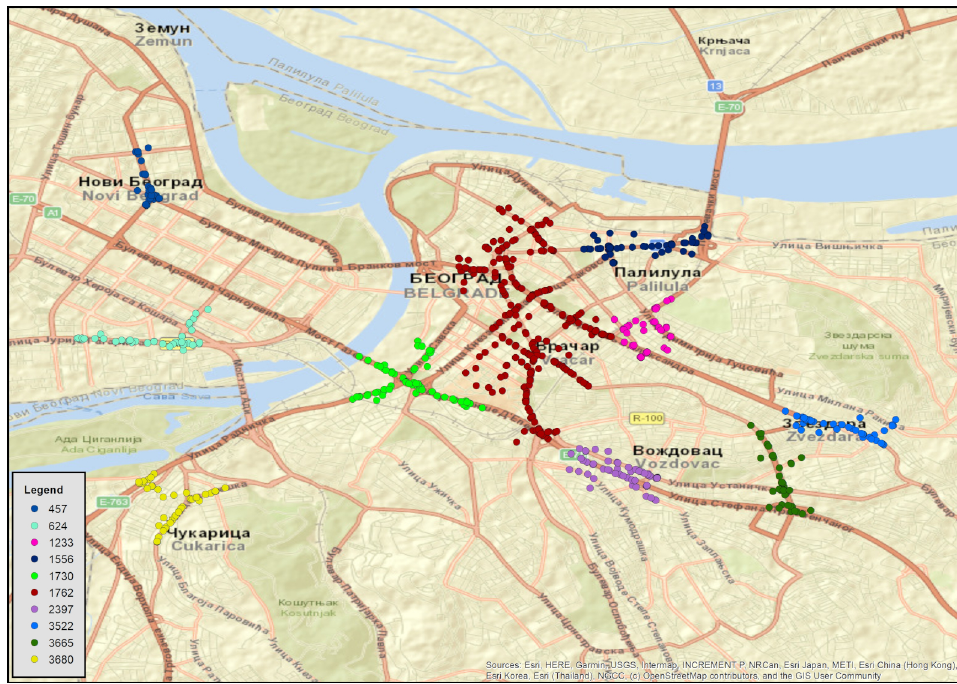
Figure 3. The map representation of the selected clusters, Belgrade, 2021. The map was generated using the ArcMap component of the Esri’s ArcGIS suite